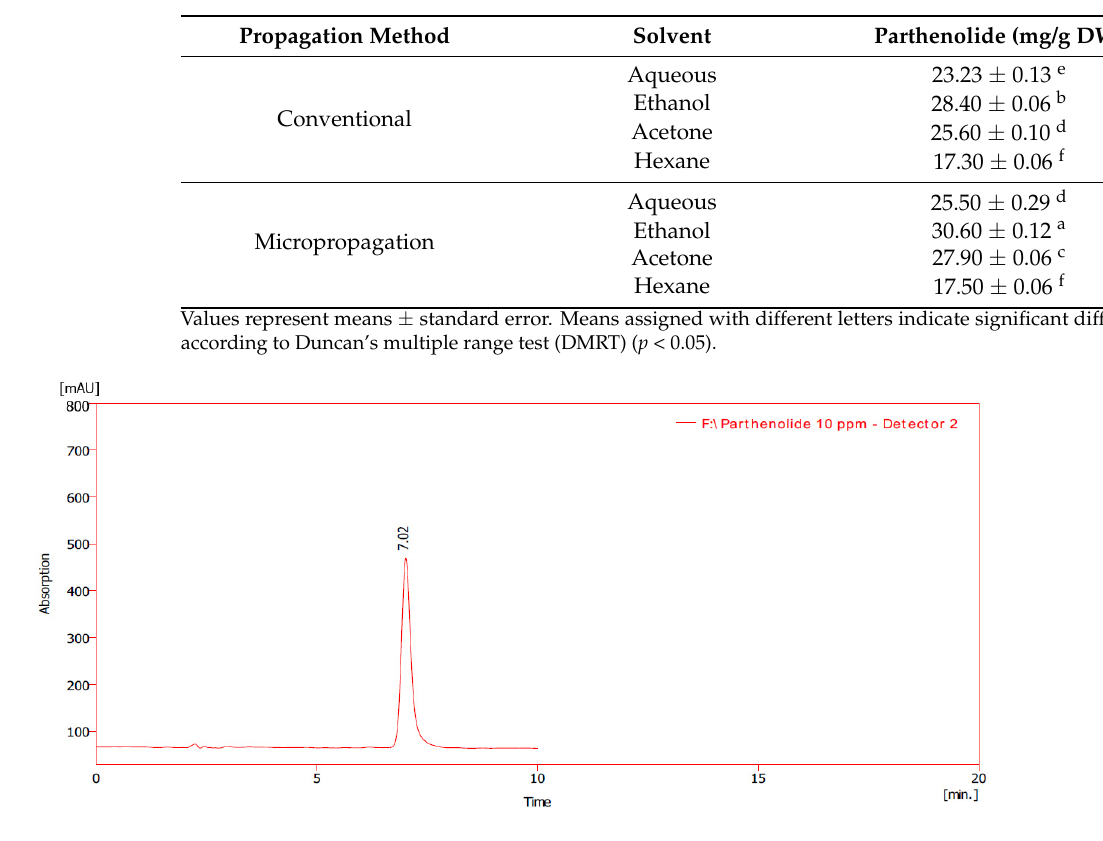
Table 5. Parthenolide content (mg/g DW) of micropropagated and conventionally grown feverfew plants’ leaves analyzed by HPLC using different solvent extracts.